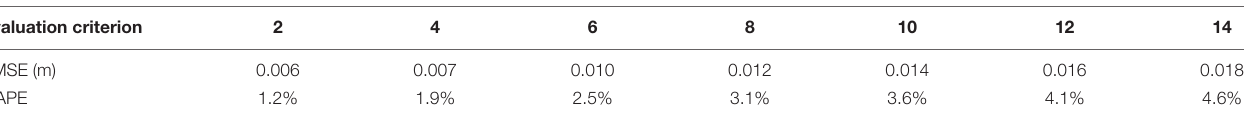
FIGURE 8 | Increment prediction evaluation and effective sub-region selection. (A) Increment prediction evaluation in the 7-day duration, with SLA ground truth on the left and the predicted values on the right. (B) Increment prediction evaluation in the 14-day duration, with SLA ground truth on the left and the predicted values on the right. TABLE 6 | Effective sub-region